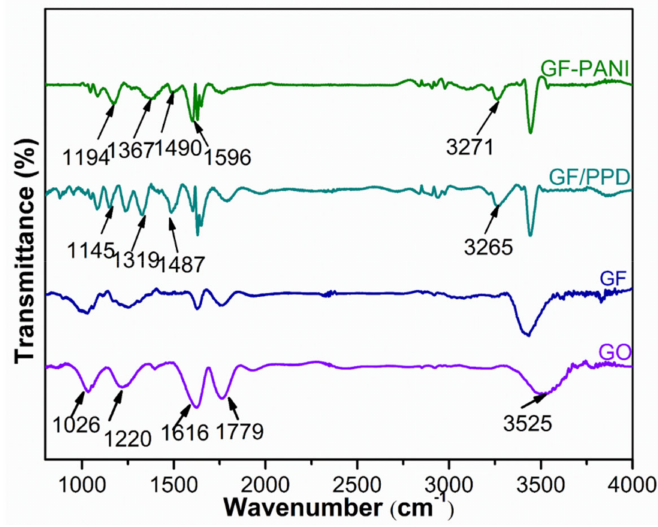
Figure 3. FTIR spectra of the GO, GF, GF/PPD, and